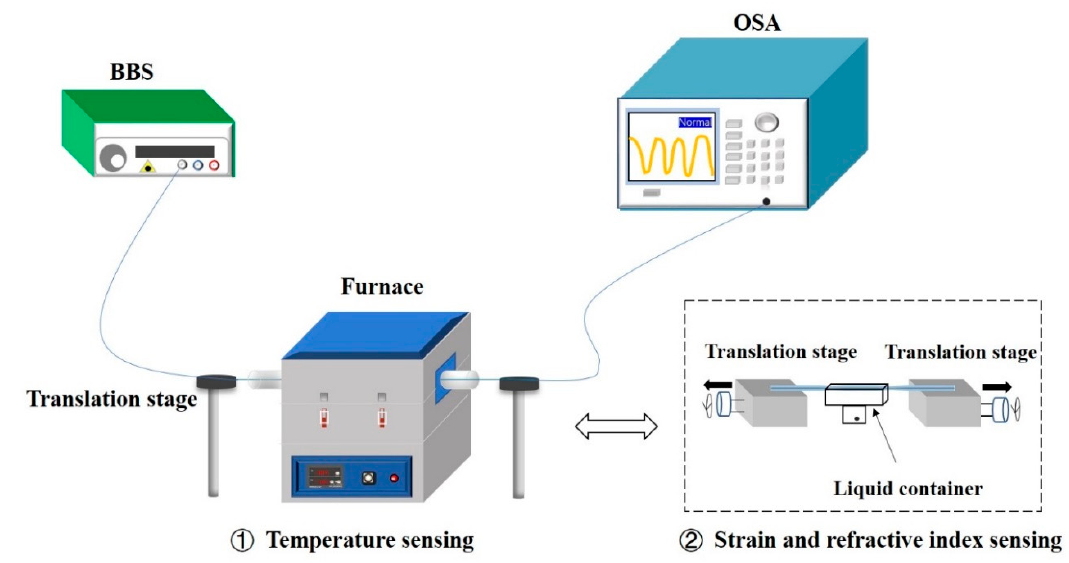
Figure 4. Schematic diagram of experimental setup for temperature, strain, and refractive index (RI) measurements.